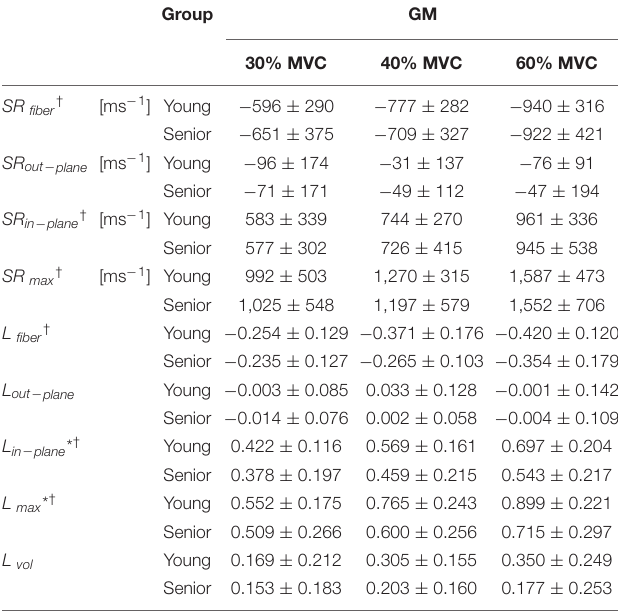
TABLE 2 | Peak strain rate and strain indices for a region of interest in GM averaged across young and senior subjects.